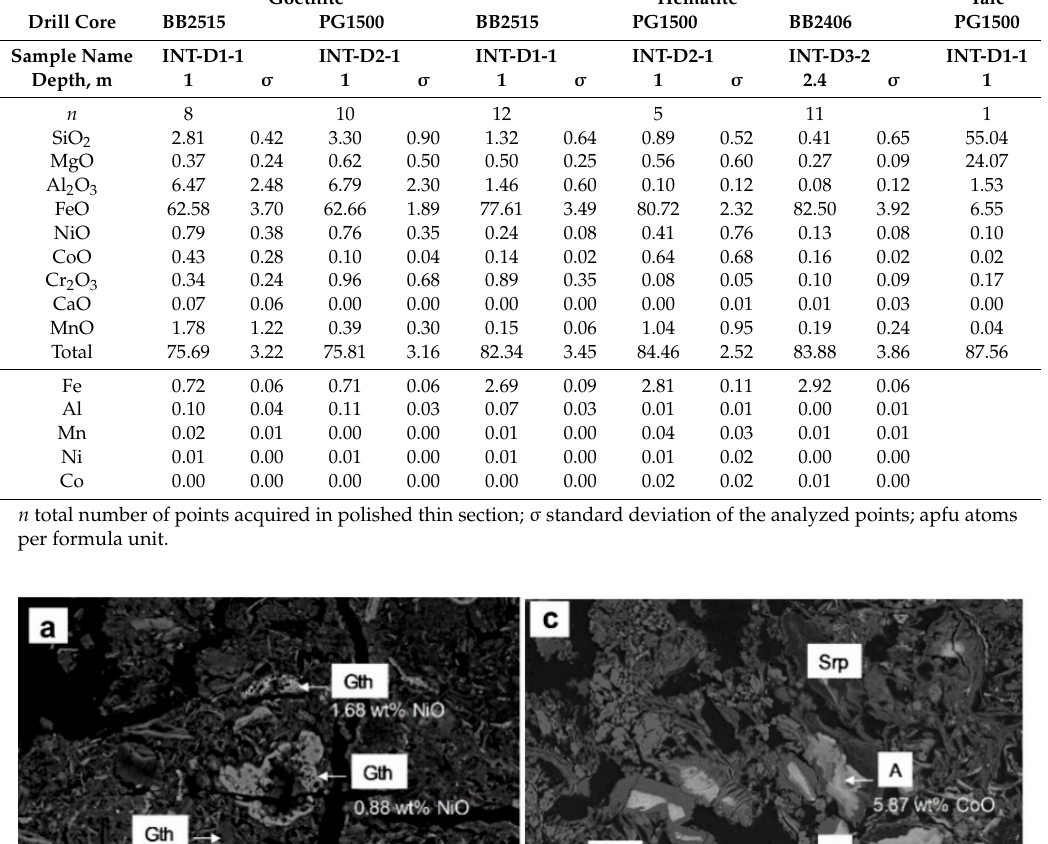
Table 5. Average compositions (wt%) and structural formula (apfu) of goethite, hematite, and talc in the limonite samples. Goethite Hematite Talc Drill Core